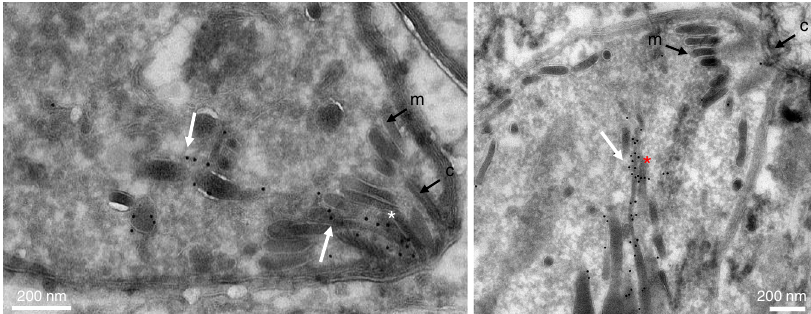
Fig. 2 TgRASP2 accumulates at the extremity of rhoptries. Immuno-electron microscopy of TgRASP2-HA 3 tachyzoites using an anti-HA antibody. The white arrows point to the gold particles associated with the rhoptries. The white asterisk indicates the rhoptry neck inside the conoid and the red asterisk the accumulation of gold particles at the extremity of a rhoptry. m: micronemes, c: to the surface of the rhoptries (Fig. 1d and Supplementary Fig. 1c), and thus do not enter the secretory pathway. Immuno- electron microscopy further con fi rmed the localisation of TGGT1_315160 to the rhoptry surface (Fig. 2, white arrowhead, Supplementary Fig. 1d), including around the neck of rhoptries